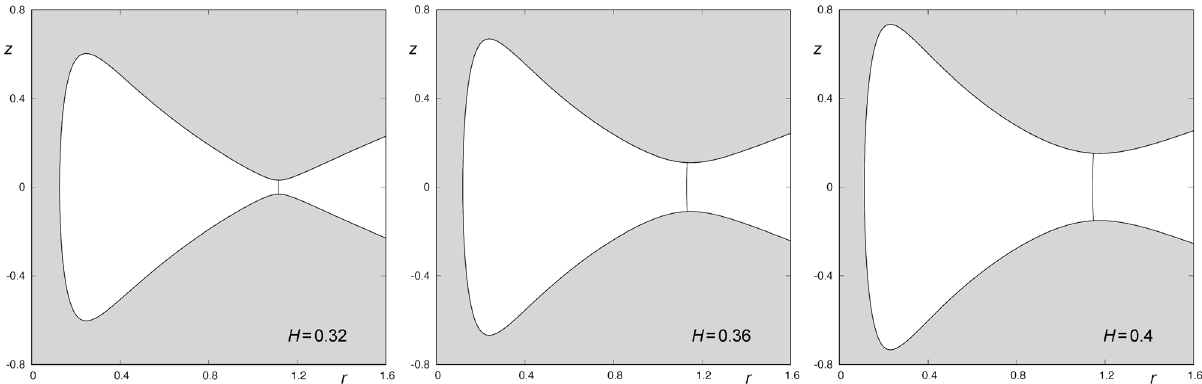
Figure 1. Curves of zero velocity for ω = 1 , µ = 1 , α = 0.2 , ρ = − 1.2 , L z = 0.1 and H 1 = 0.32 (left panel), H H 3 = 0.4 (right panel). The almost straight line barring the opening of the potential is the 2 = 0.36 and Lyapunov orbit. This graphic has been generated by using Gnuplot Version 5.2. http:// www. gnupl ot.